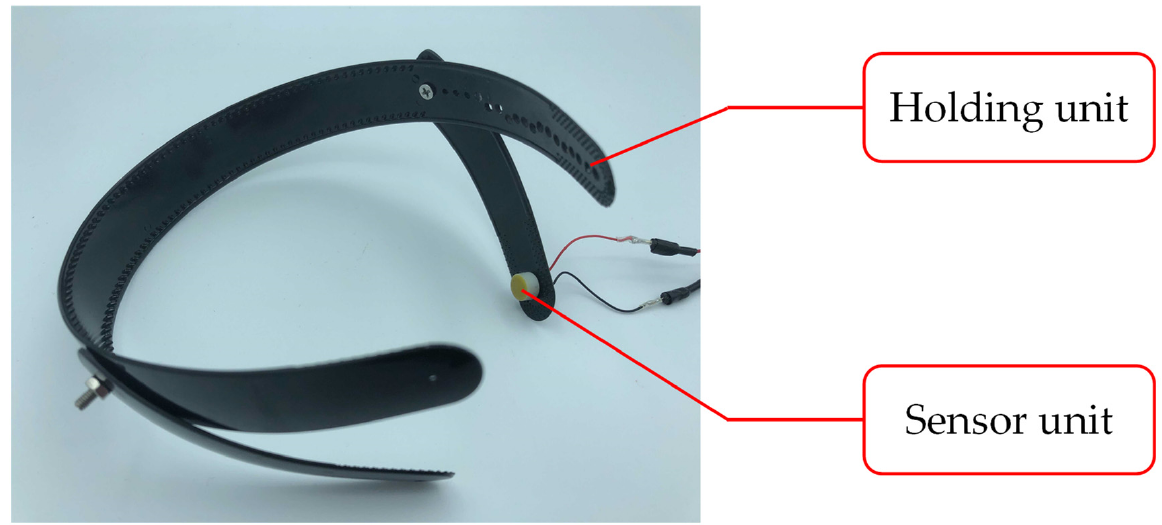
Figure 1. Biological sound sensor.